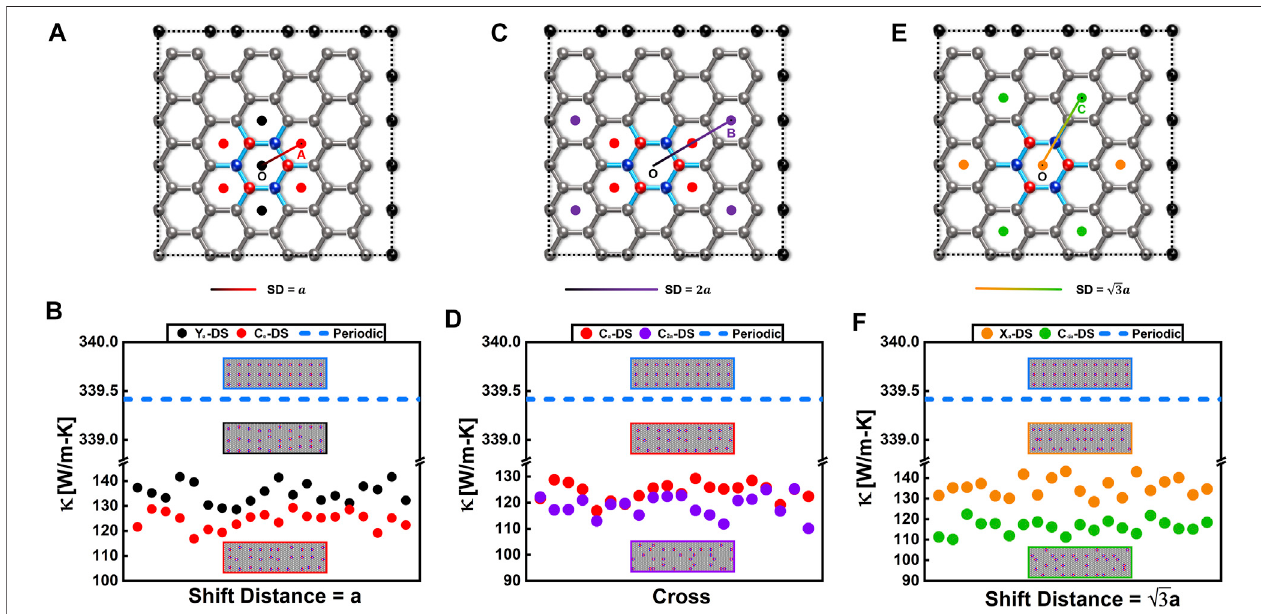
FIGURE3| Qualitativeanalysisoftheeffectofdisorderonthermalconductivityat300 K (A) – (B) Schematicdiagramsof Y a -DSand C a -DSandtheircorresponding thermal conductivity. (C) – (D) Schematic diagrams of C a -DS and C 2 a -DS and their corresponding thermal conductivity. (E) – (F) Schematic diagrams of C (cid:1) 3 √ a -DS and X (cid:1) 3 √ a -DS and their corresponding thermal